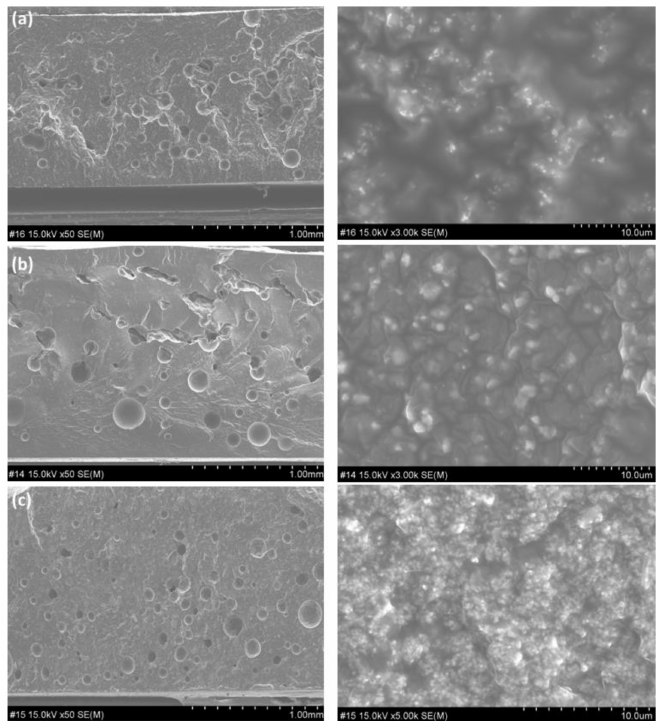
Figure 6. SEM images of sheet cross-sections providing a comparative analysis of the oyster shell particle morphology in the plastic working state: ( a ) untreated oyster shell particles, ( b ) particles after plastic working at 600 ◦ C, and ( c ) particles after plastic working at 1200 ◦